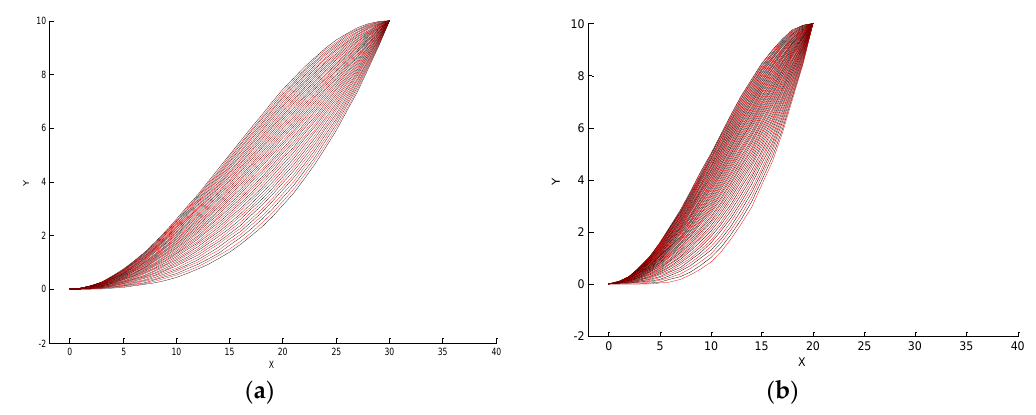
Figure 9. Trajectory clusters under different target points; ( a ) (30, 10, 0~45°); ( b ) (20, 10, 0~60°).